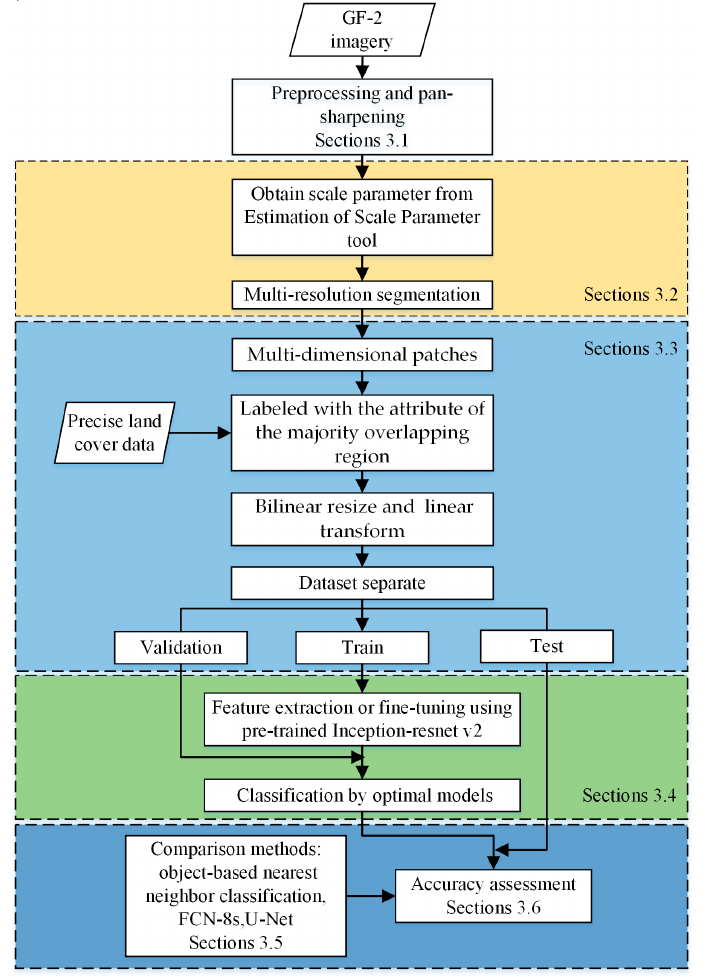
Figure 3. Outline of the overall framework presented in this paper, including image preprocessing, classification, and comparison methods. classification, and comparison